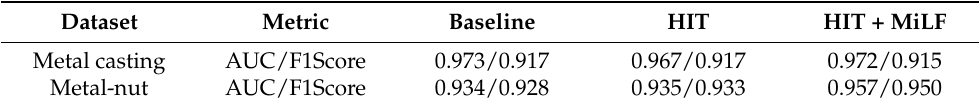
Table 2. Baseline results on ideal testing